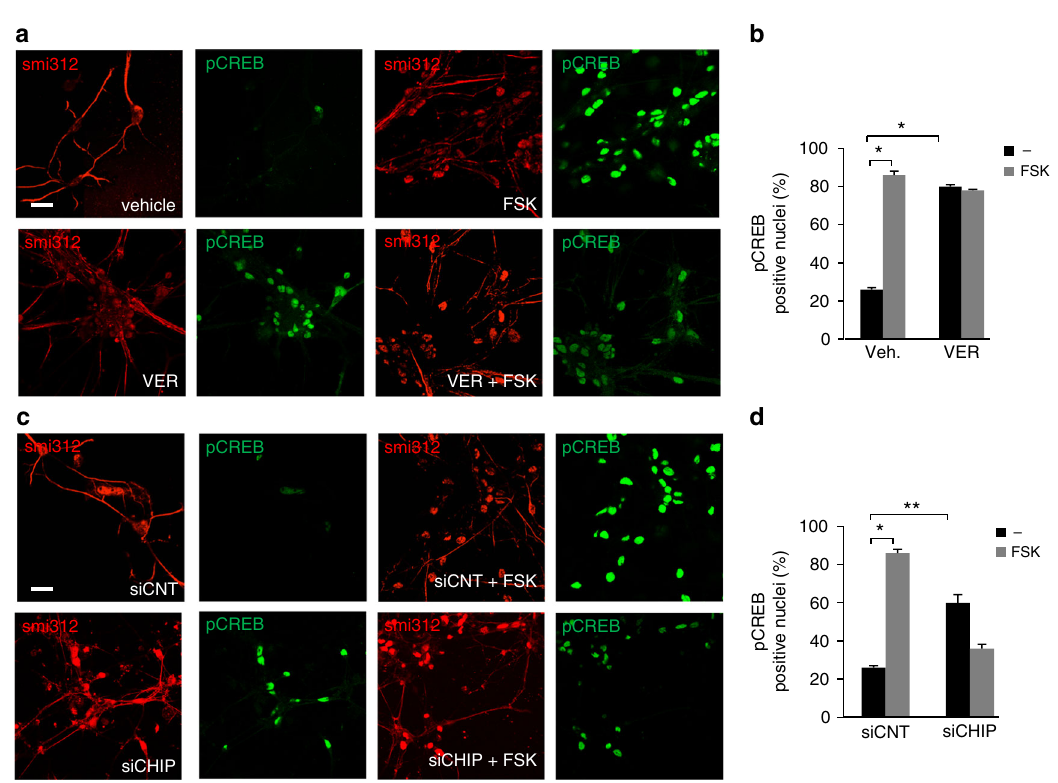
Fig. 7 CHIP regulates cAMP signaling in neurons. a Primary hippocampal neurons were left untreated or stimulated with FSK (40 μ M/30 min). Where indicated, cells were pretreated with VER155008 or vehicle. Formalin- fi xed neurons were immunostained for pCREB and smi312, a neuro fi lament marker, and analyzed by confocal microscopy. Scale bar, 20 μ m. b Quantitative analysis of the experiments shown in a . A mean value ± S.E.M. of three independent experiments is shown. Student ’ s t test, * p < 0.05. c Primary hippocampal neurons were transfected with siRNAs (control or siRNA targeting CHIP), serum deprived overnight and stimulated with FSK (40 μ M/30 min). Formalin- fi xed neurons were immunostained for pCREB and smi312. Scale bar, 20 μ m. d Quantitative analysis of the experiments shown in c . A mean value ± S.E.M. of three independent experiments is shown. A total of 50 – 100 cells were scored in each set of experiments. Student ’ s t test, ** p <